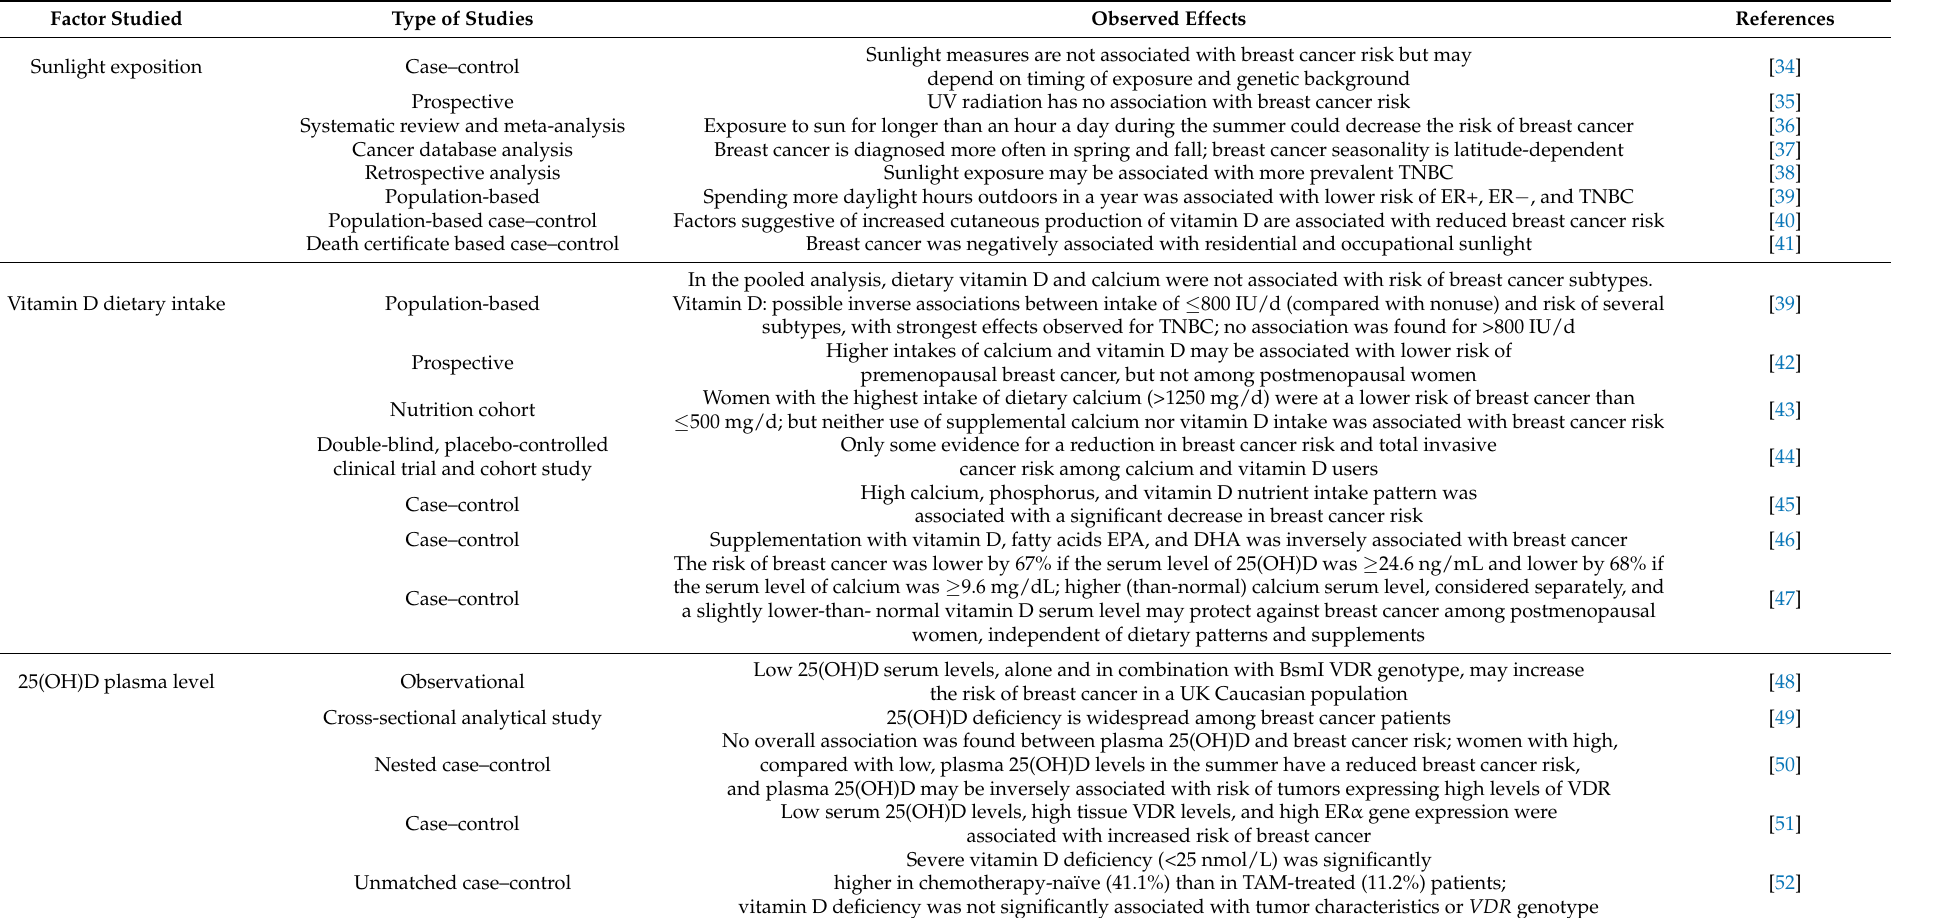
Table 1. Examples of clinical/epidemiological data regarding the impact of vitamin D on breast cancer